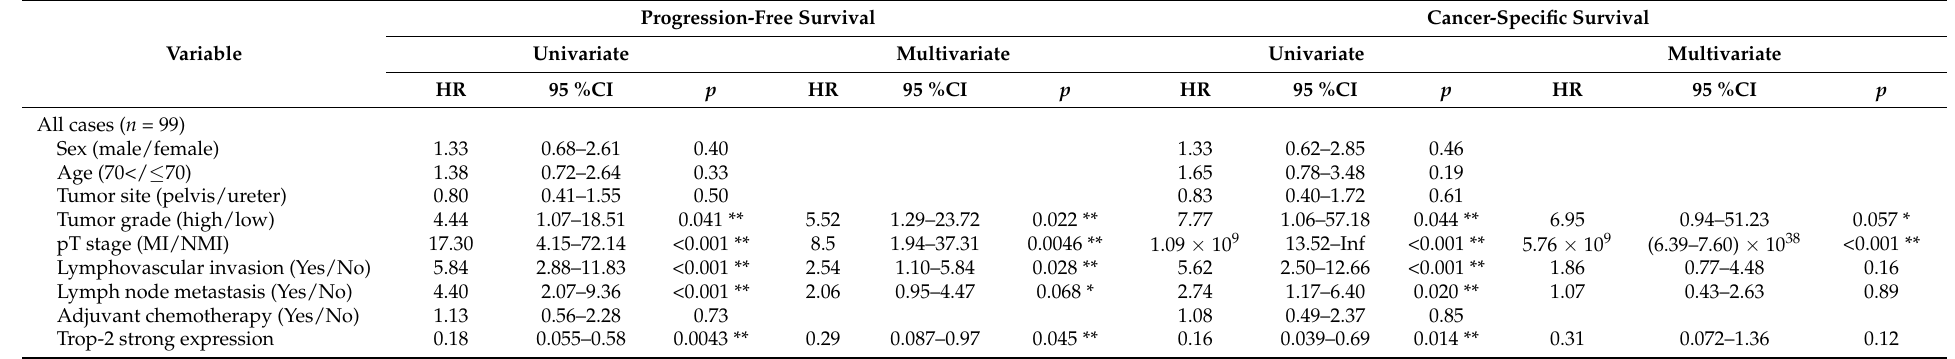
Table 3. Univariate and multivariate analyses of progression-free survival and cancer-specific survival in patients with upper tract urothelial carcinoma. Progression-Free Survival